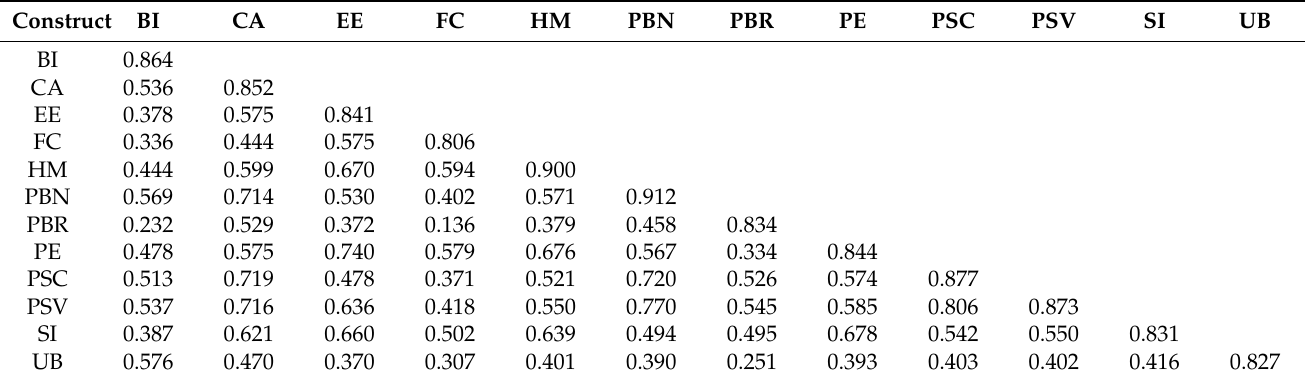
Table 7. Discriminant validity: the Fornell–Lacker criterion.